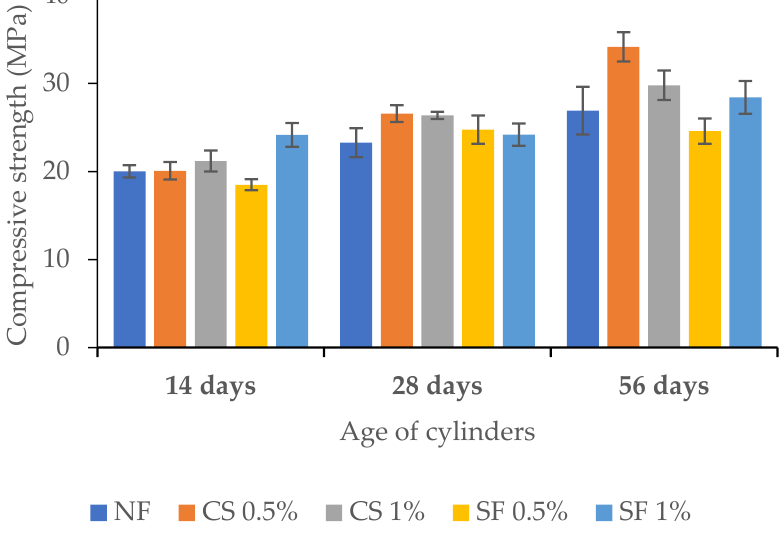
Figure 4. Effect of fiber percentage on compressive strength (base dosage of 20.59 MPa).